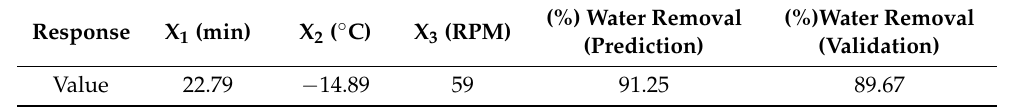
Table 5. Validation value for optimum conditions of